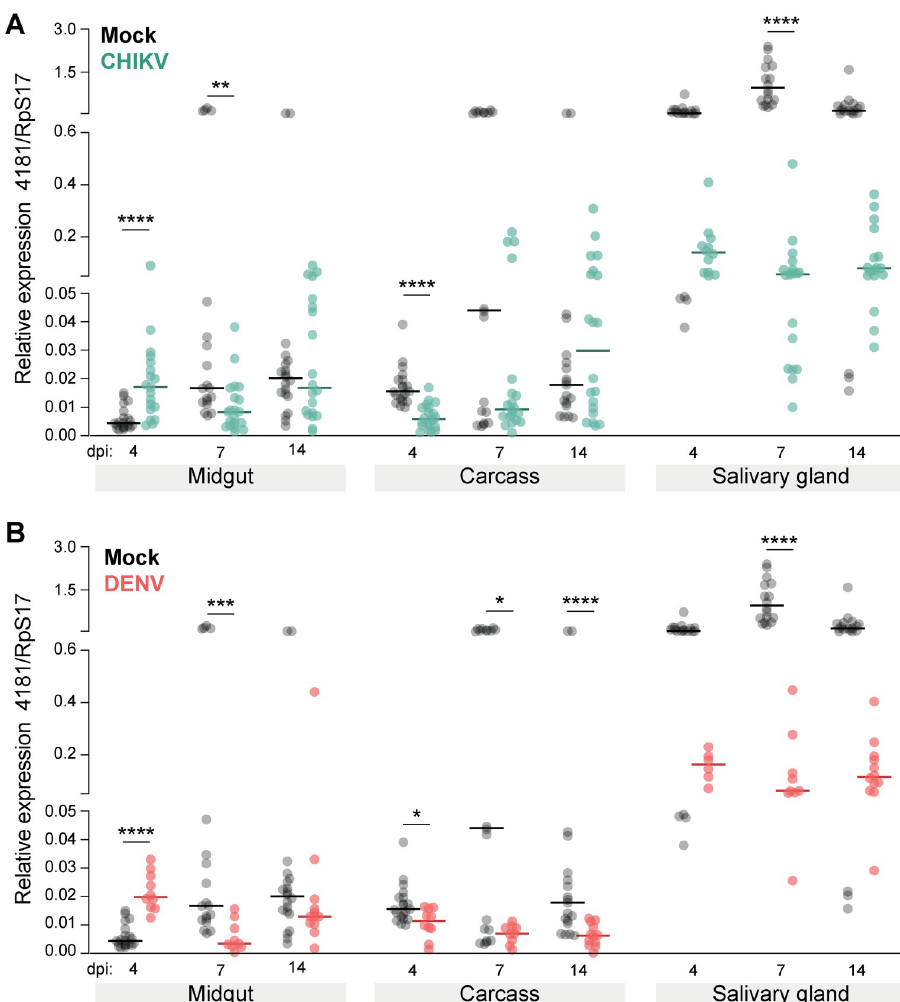
Fig 5. Tissue-specific expression of AAEL004181 across time in (A) CHIKV- and (B) DENV-infected mosquitoes compared to expression in mock controls. Points depict relative expression level of AAEL004181 in individual samples, while horizontal lines mark group medians. Significance was evaluated by Mann-Whitney U tests between mock and control. * P < 0.05, ** P < 0.01, *** P < 0.001, **** P < 0.0001. Note that a day 7 salivary gland outlier in the mock treatment group has been omitted from both panels (value = 7.618). dpi, days post-infection. n = 20 per